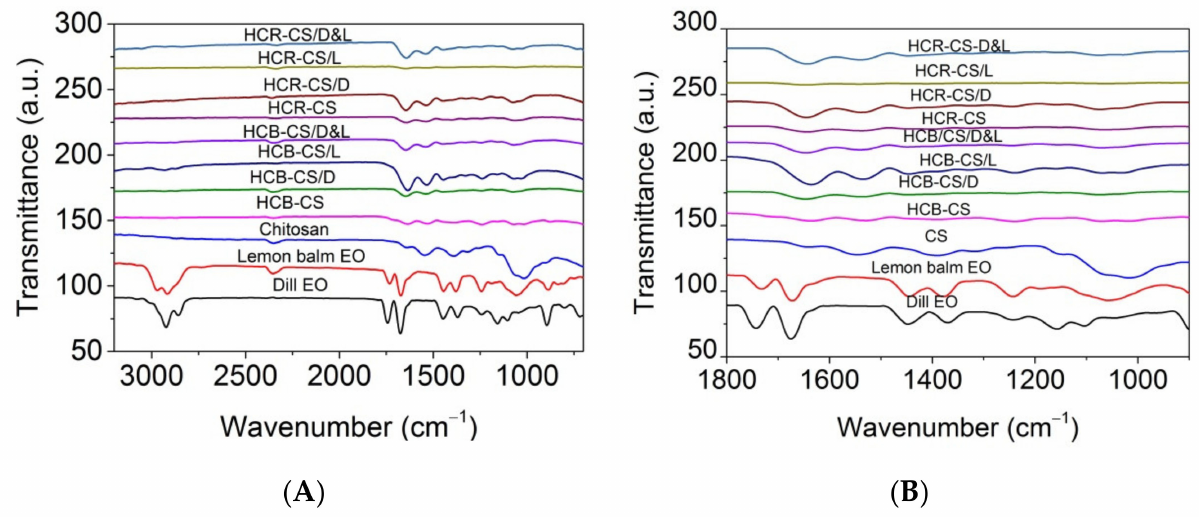
Figure 5. ATR-FTIR spectra for collagen hydrolysate-chitosan/essential oils electrospun nanofibers as compared with dill EO, lemon balm EO, and chitosan in the range between 4000 and 700 cm − 1 ( A ); between 1800 and 900 cm − 1 ( B ). The spectra of HCB-CS and HCR-CS complexes indicated that the amide I of chitosan from 1639 cm − 1 (stretching vibrations of peptide C=O groups) moved to 1663 cm − 1 and 1635 cm − 1 , respectively. The amide II (1545 cm − 1 ) associated with the secondary